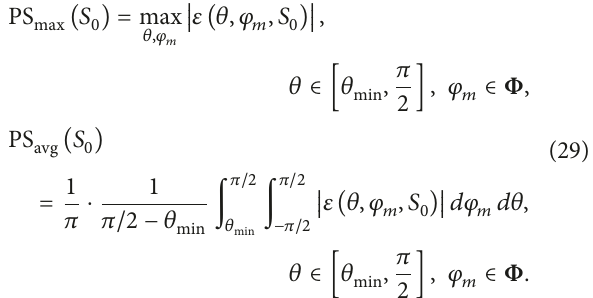
reduce the difficulty of installation (the red line) and maintain an acceptable error